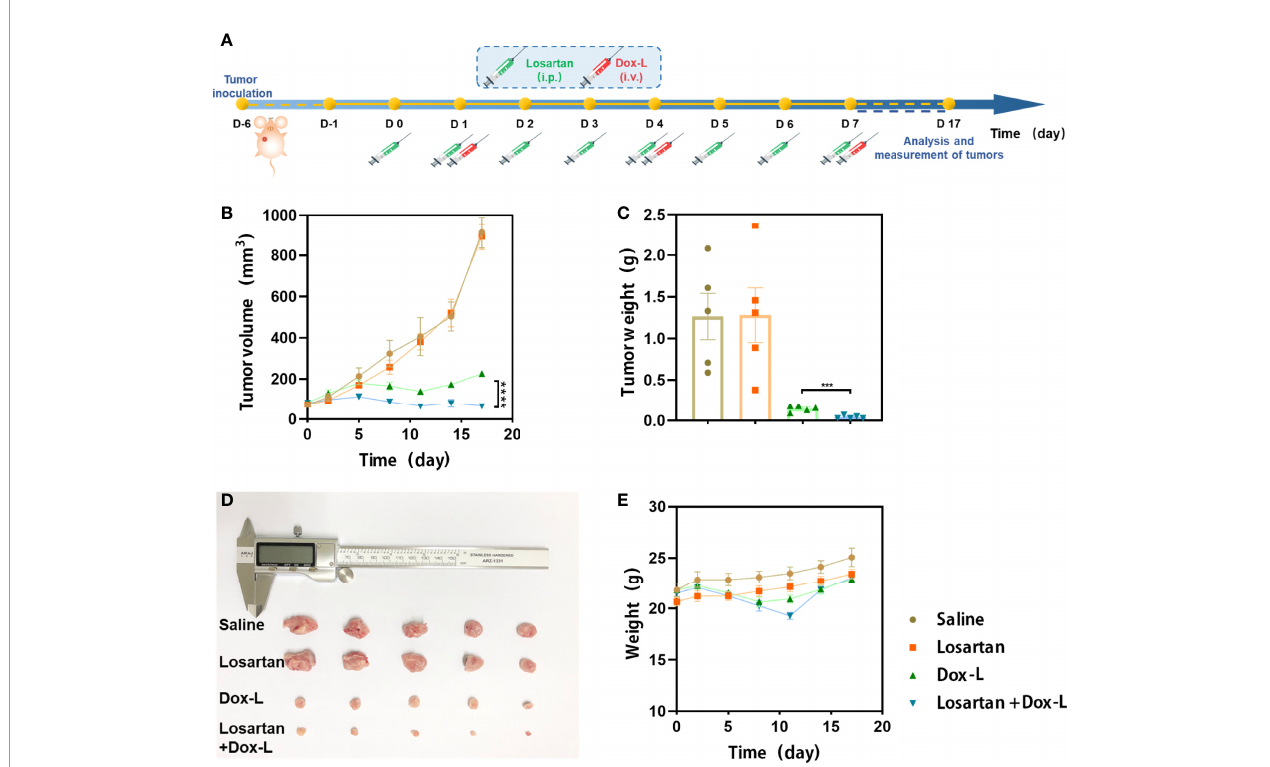
FIGURE 1 | Losartan signi fi cantly inhibits the growth of tumors treated with Dox-L. (A) Schematic illustration of losartan and Dox-L combination therapy to tumor models (n = 5). (B) Average tumor growth curves of 4T1-tumor-bearing mice from different groups of mice. (C) Average weights of tumors at the end of treatments. (D) Photographs of excised tumors at the end of treatments. (E) Weight of mice after different treatments. Data are expressed as the mean ± SEM. Data are expressed as the mean ± SEM. Statistical signi fi cances were calculated via Student ’ s t-test, ***p < 0.001 and ****p <